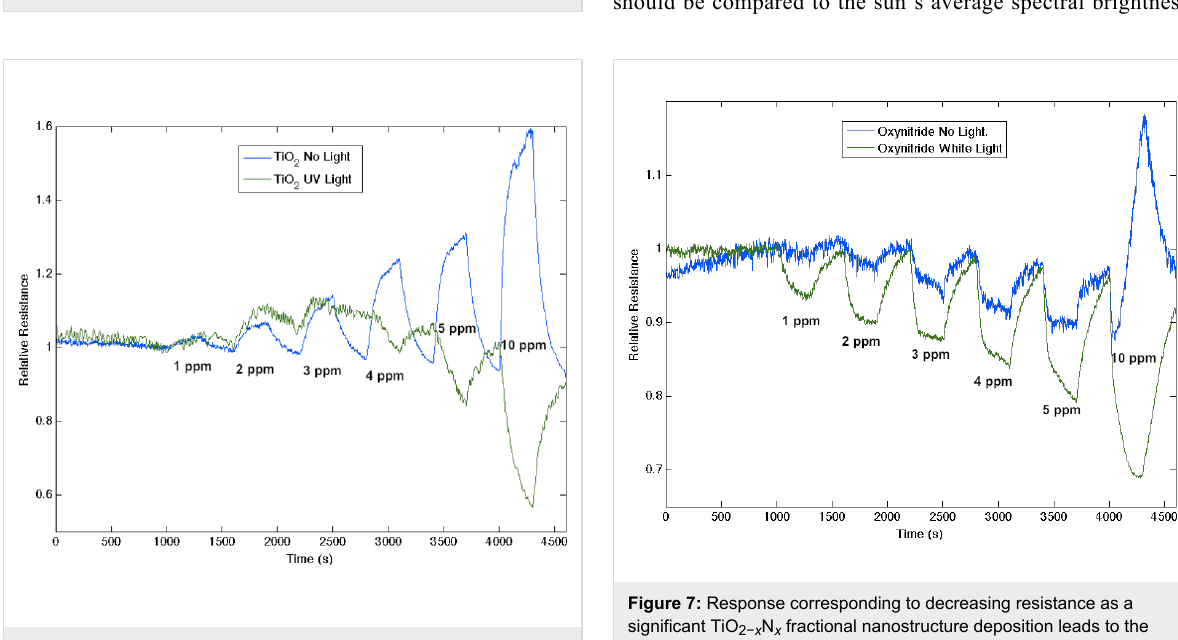
Figure 5: Response corresponding to decreasing resistance as NH 3 contributes electrons to a TiO 2 treated n-type PS interface without light exposure and the same interface exposed to UV radiation, which makes the TiO 2 more acidic, increasing electron extraction and conductance.